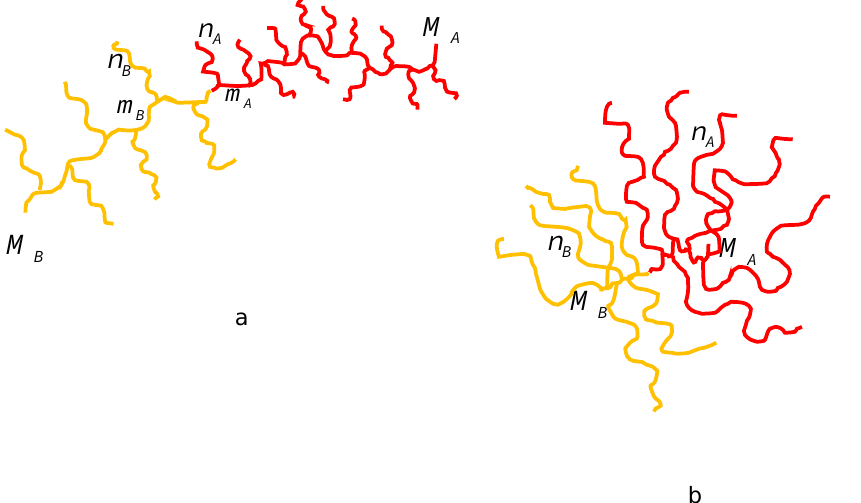
Figure 1. Schematics of bottlebrush ( a ) and miktoarm star ( b ) diblock copolymer for a particular case of branching activity q A = q B =